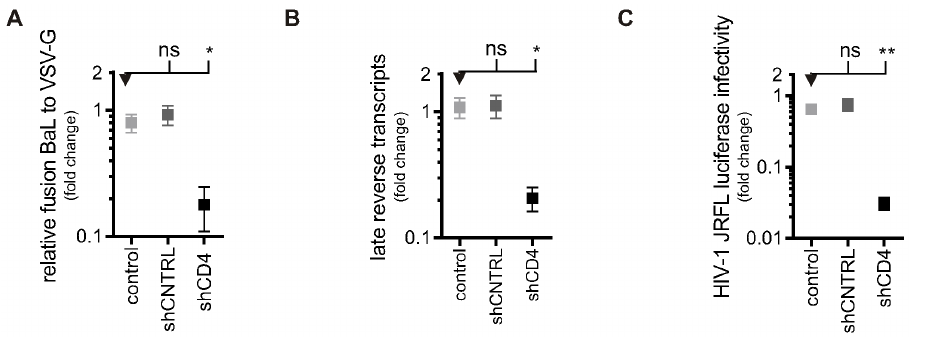
Figure 4. HIV-1 infection is reduced in CD4-knock-down macrophages. A) HIV-1 viral fusion in PSC-macrophages. The percentage of fusion of HIV-1 virions was normalised to the percentage fusion of VSV-G-pseudotyped virions. Symbols represent the normalised mean fusion relative to the PSC-macrophages CD4 WT group (shown in Figure 7) of four independent experiments 6 SEM (n=4). B) Reverse transcription of HIV-1 in PSC- macrophages. Late (pol) products were detected by qPCR after 30 h of infection. Symbols represent the relative mean number of copies of HIV-1 DNA 6 SEM of independent experiments (n=4), normalised to the number of cells using a b -actin control. C) HIV-1 productive infection in PSC- macrophages Infection was measured by detecting luciferase activity in PSC-macrophages three days after transduction with NL4.3.Luc.R-E- virus pseudotyped with HIV-1 or VSV-G envelope. HIV-1 NL4.3.Luc.R-E- transduced cells were normalised to VSV-G NL4.3.Luc.R-E- transduced cells. Symbols represent the mean luciferase detection relative to the PSC-macrophages CD4 WT group (shown in Figure 7) 6 SEM of independent experiments (n=4).